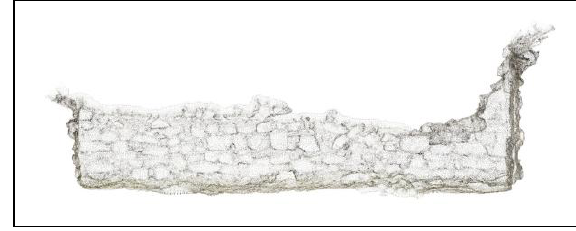
Figure 4. Wall Section Dense Cloud